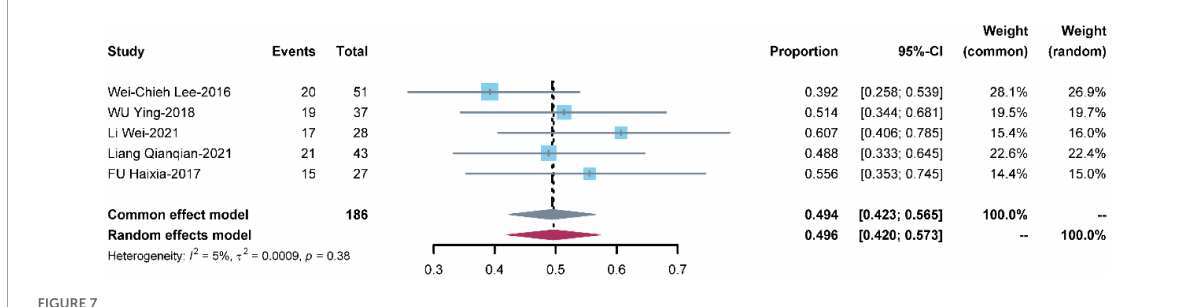
FIGURE7 Meta-analysis of the prevalence of renal